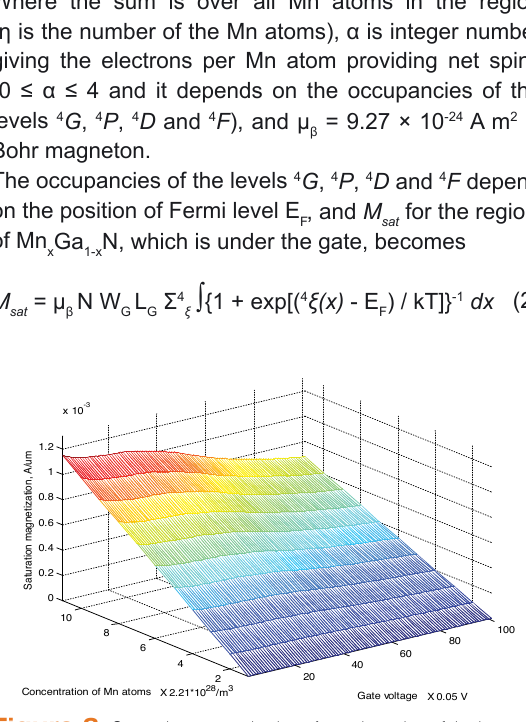
Figure 3. Saturation magnetization of certain region of the layer